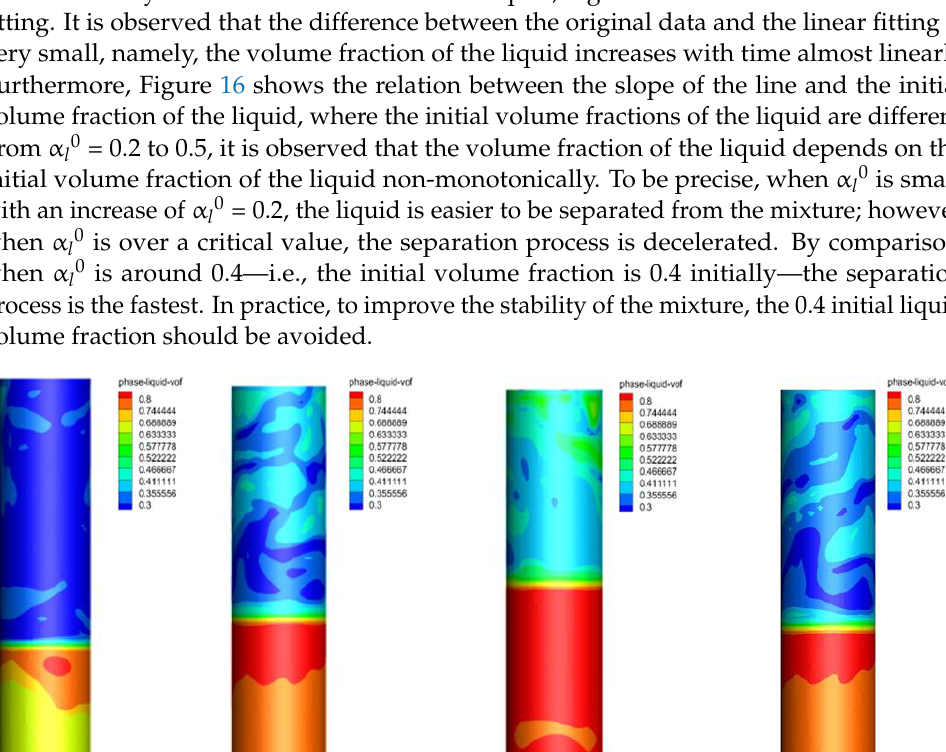
Figure 13. Distribution of the liquid volume fraction at t = 50 s, α l 0 = 0.2, 0.3, 0.4, and 0.5.